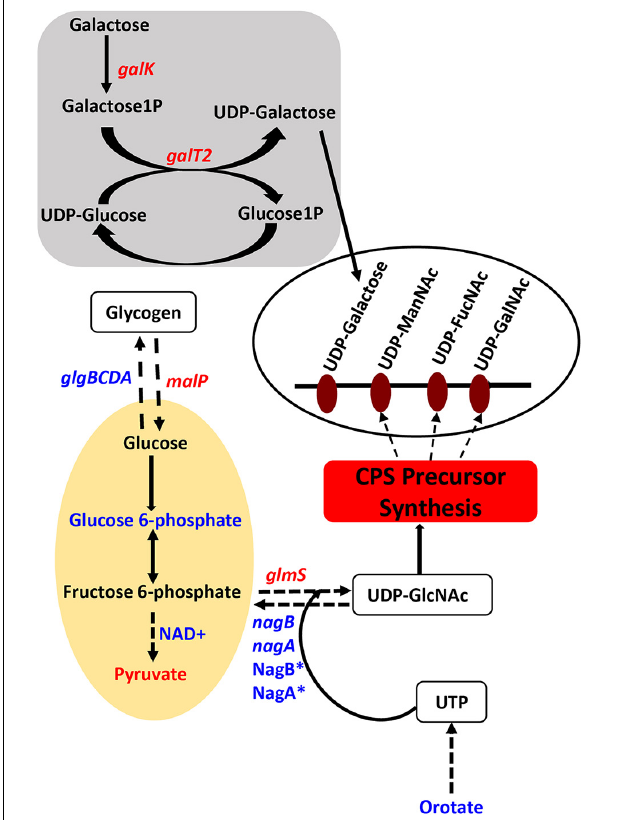
FIGURE 1 | Impaired polyamine synthesis in S. pneumoniae impacts the availability of precursors for capsule (CPS) synthesis. Characterization of a putative lysine decarboxylase deletion strain of S. pneumoniae TIGR4 by RNA-Seq and metabolomics identified changes (blue represents increase and red represents decrease) in the genes (italicized) and metabolites in the deletion strain relative to the wild type that could explain the previously reported loss of the capsule. The deletion strain is impaired in the interconversion of UDP-Glu and UDP-Gal via the Leloir pathway (gray square) due to the reduced expression of galk and galT2 genes, that can reduce the availability of UDP-Gal precursor of the repeat unit of the serotype 4 capsule (open white oval). Carbon flux through glycolysis (yellow oval) is reduced in (cid:49) cadA confirmed by the accumulation of glucose 6-phosphate and NAD + , intermediates of the pathway and reduced levels of the end product pyruvate. Enzymatic reactions are shown as black arrows and multi-step reactions are represented by a broken arrow. Upregulation of N -acetylglucosamine-6- phosphate deacetylase (NagA ∗ ) and GlcN6P deaminase (NagB ∗ ) that could degrade intermediates of UDP-GlcNAc, at the protein level, was earlier reported and was observed at the RNA level in this study. Reduced synthesis of UDP-GlcNAc due to reduced expression of glmS and increased degradation due to higher expression of nagA and nagB will limit the availability of this nucleotide sugar substrate for epimerases that synthesize all three acetylated UDP-sugars of the repeat unit. Accumulation of orotate indicates impaired ability to synthesize UTP, a precursor for UDP-GlcNAc synthesis. The net effect of these changes in metabolism in (cid:49) cadA results in the reduced availability of precursors for CPS synthesis (red